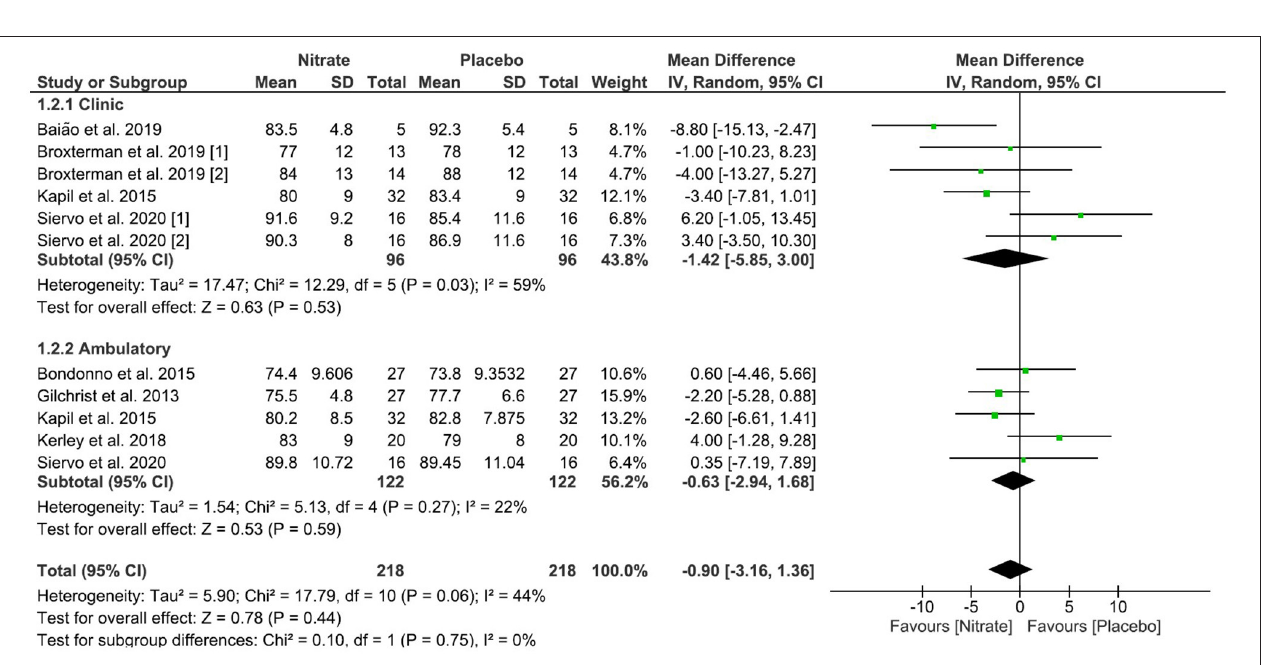
FIGURE 3 | Effects of NO 3 derived from BRJ on SBP (mmHg) values.